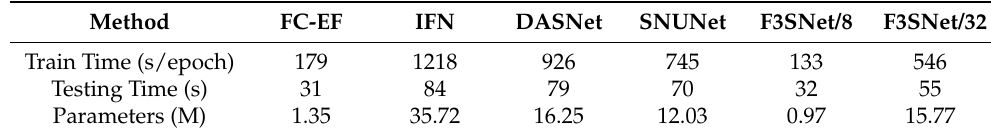
Table 2. Time performances of different methods.